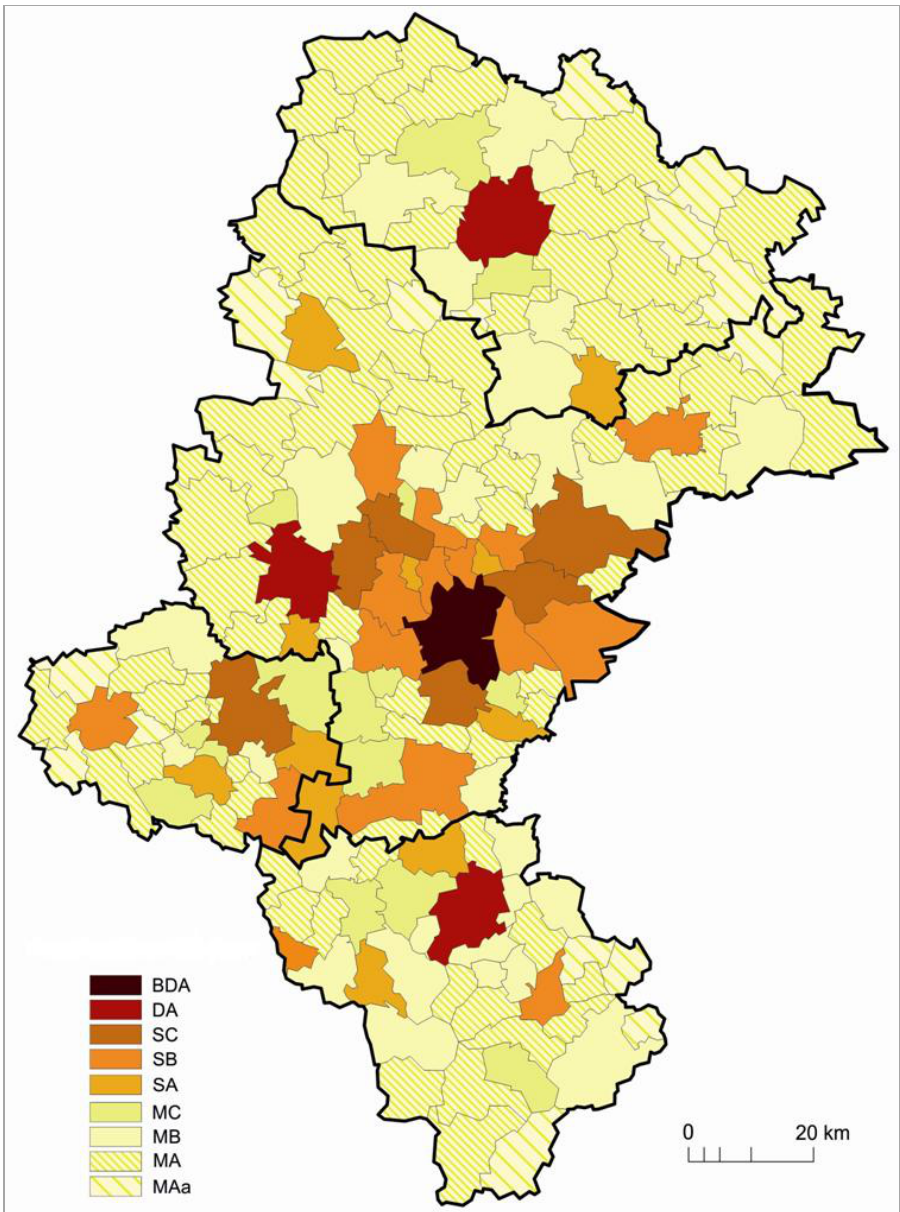
Fig. 1. Classification of local labour markets in the Silesian Province based on a number of the employed in 2010 (source: Sitek et al, 2013, p. 188). The justifications of abbreviations in the